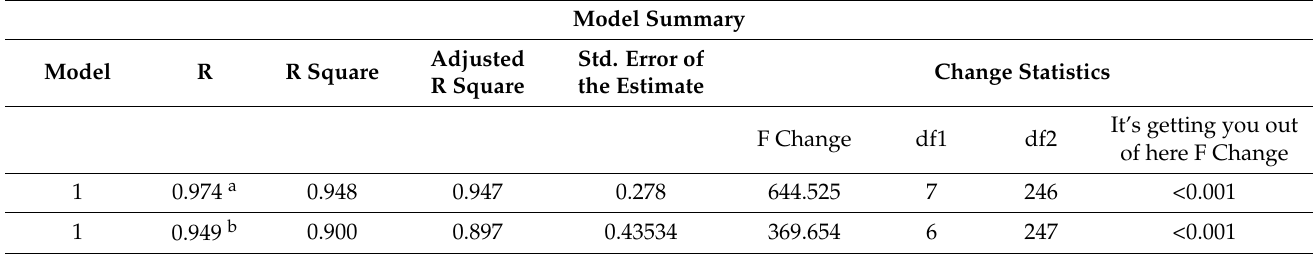
Table 15. Multiple regression analysis between the independent variables and the dependent variable. Model